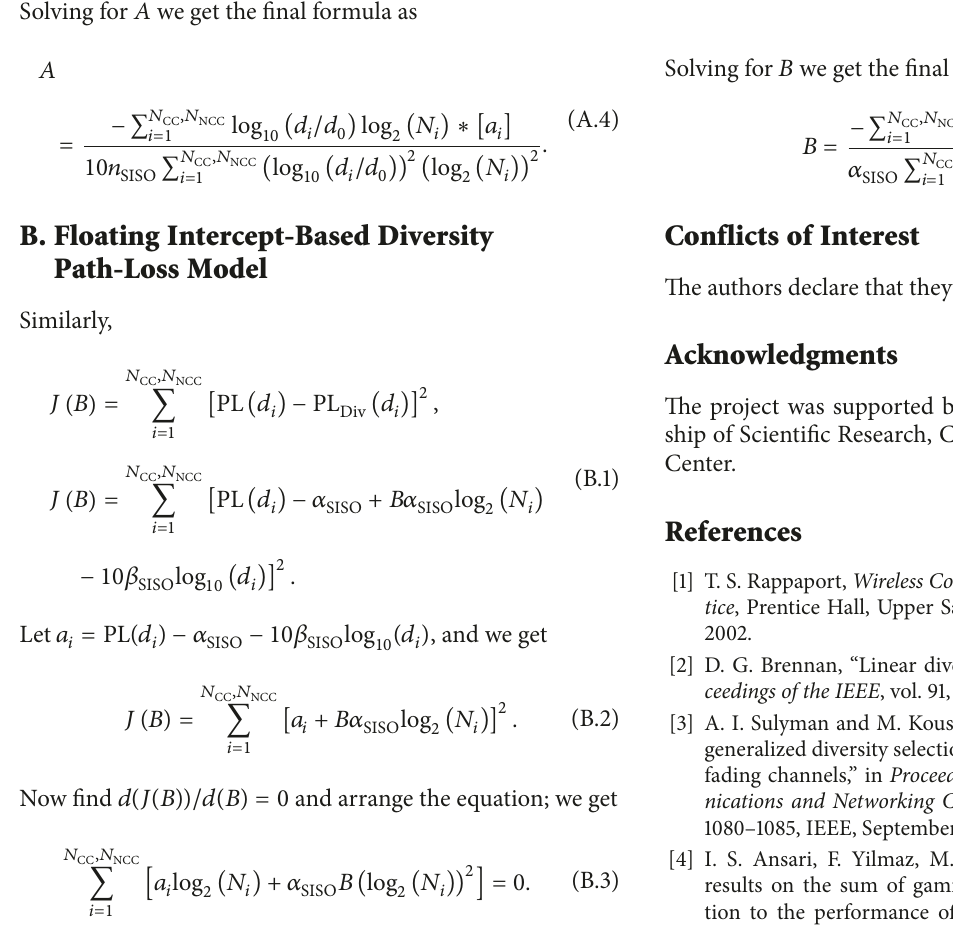
Figure 20: Path-loss prediction for arbitrary number of combined signalsusingtheproposedgeneralreceiverdiversitypath-lossmodel given by (6), for the NLOS CC case with 𝛼 SISO = 31.36 and 𝛽 SISO = 1.53 along with 𝐵 = 0.276 from Tables 2 and 3,